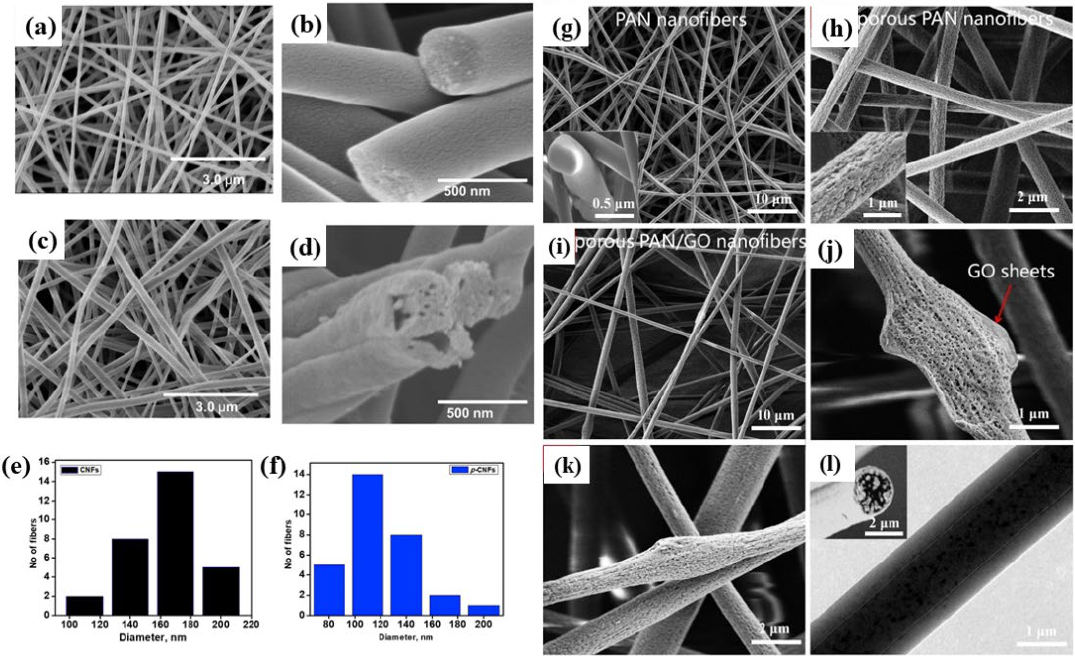
Figure 6. ( a , b ) SEM photos of CNF; ( c , d ) SEM photos of p‑CNF; ( e , f ) the diameter distribution diagrams of CNF and p‑CNF, respectively. Reprinted with permission from ref. [53]. Copyright 2019 Elsevier; ( g ) PAN; ( h ) porous PAN; ( i ) SEM and TEM images of porous PAN/GO nanofibers; ( i – l ) porous structure on the shell and core of porous PAN/GO nanofibers (inset: cross section membrane performance). Reprinted with permission from ref. [54]. Copyright 2020 Elsevier.